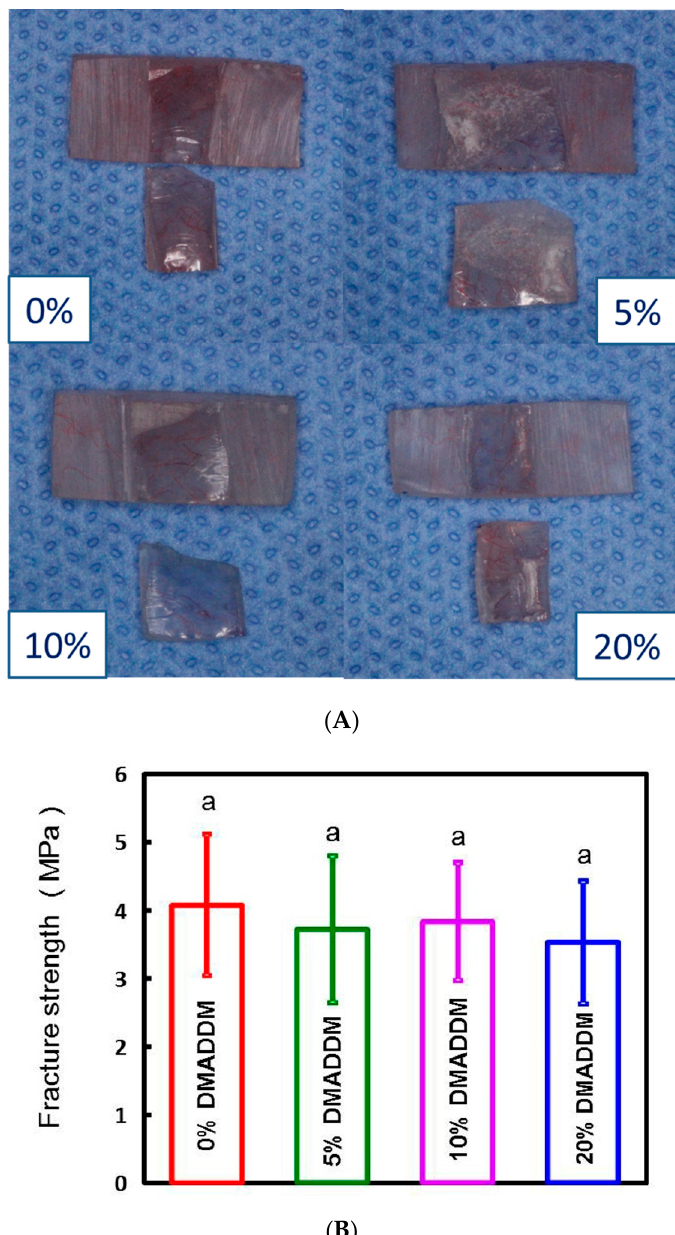
Figure 3. ( A ) The fractured face of different concentration of DMADDM samples in bond quality test; ( B ) The fracture strength of different DMADDM concentration samples. In each plot, the same letter indicates that there was no significant difference between the groups ( p > 0.1).